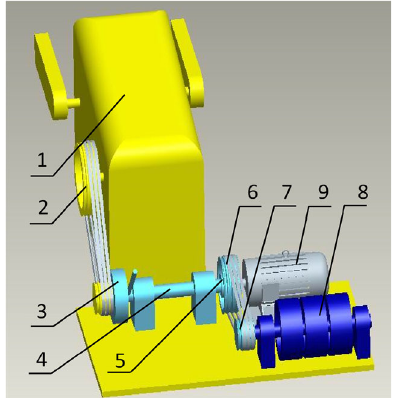
Fig. 14 Schematic diagram of flywheel-energy-storage device (Zhao and Zhao 2009). 1 Gearbox, 2 belt pulley of gearbox, 3 clutch, 4 back shaft, 5 coupling, 6 large belt wheel for growth rate, 7 small belt pulley, 8 flywheel, 9 motor